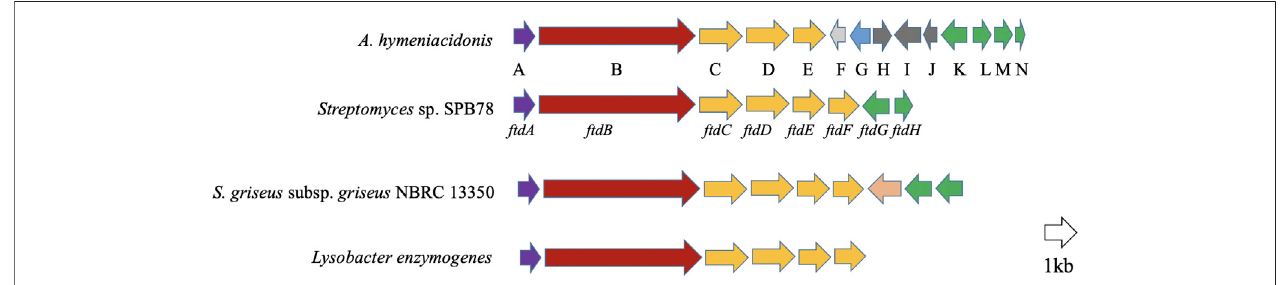
FIGURE2| Openreadingframe(ORF)mapofthepossiblexanthobaccinbiosyntheticlocusfrom A.hymeniacidonis comparedtoothercharacterizedPTMclusters in Streptomyces sp. SPB78 (frontalamides, Blodgett et al., 2010), S. griseus subsp. griseus NBRC 13350 (frontalamide-like compounds, Luo et al., 2013) and Lysobacterenzymogenes (HSAF,Yuetal.,2007).EachORFiscolor-codedtodesignateftdorthologs.Thoseshowninpurpleencodeforsteroldesturase,redforhybrid PKS-NRPS, orange for oxidoreductase and green for transporters. For A. hymeniacidonis ( Supplementary Table S1 ), there are siderophore interaction-related proteins F (siderophore-interacting protein) and G (iron-siderophore-interacting ABC transporter substrate-binding protein); H – J: proteins with unknown functions.